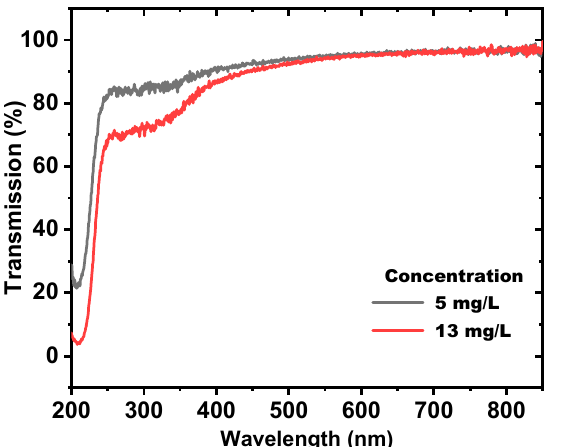
Figure 3. The transmission spectrums of ZnONPs at concentrations of 5 and 13 mg/L at 5- and 10-min ablation time.